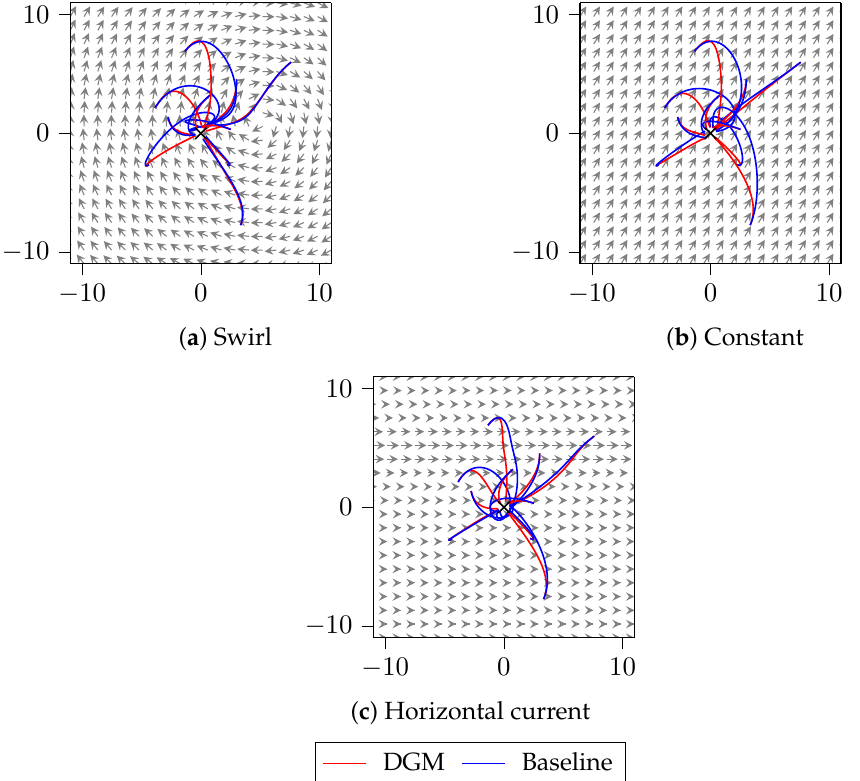
Figure 5. Example trajectories for each control law and disturbance, where the horizontal axis denotes the x coordinate, and the vertical axis is y . The vector field represents the disturbance, the red trajectories are obtained using DGM and the blue trajectories are obtained with the baseline control (17). Observe how DGM trajectories differ the most as the disturbance effect increases, thus giving a strong advantage to DGM over the baseline when the disturbance effect is not